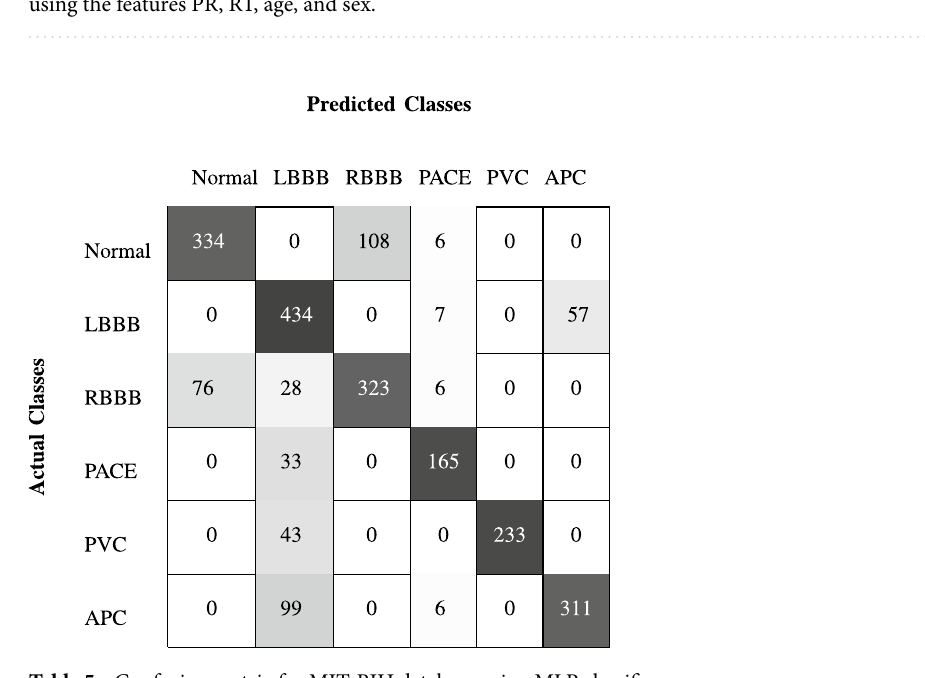
Table 4. The performance comparison of the SVM and MLP classifiers for the MIT-BIH and SPH databases using the features PR, RT, age, and sex.